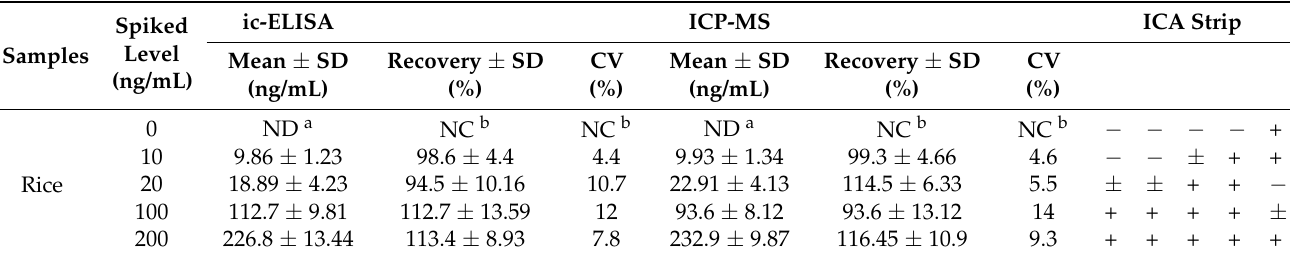
Table 2. Analysis of mercury in rice samples by the ICA strip assay (n =